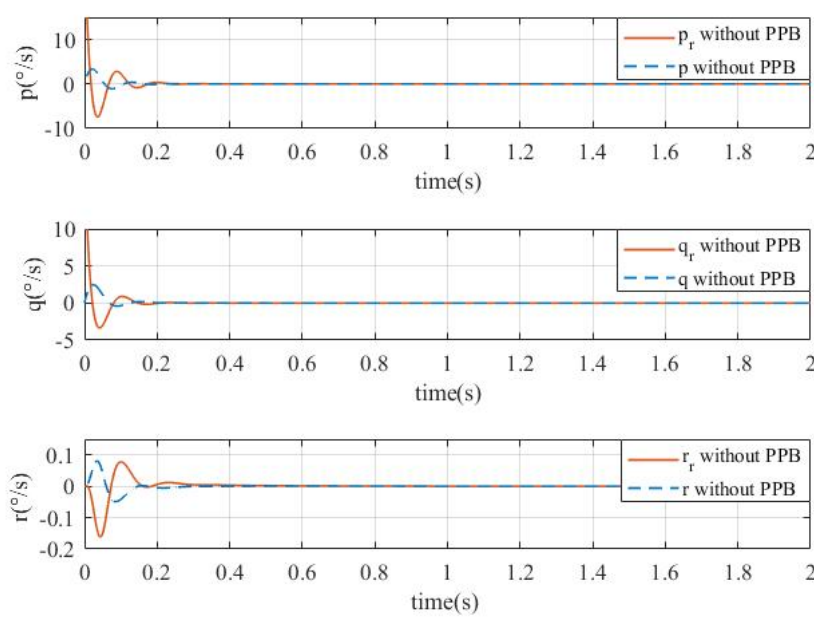
 ,  and  without PPB.